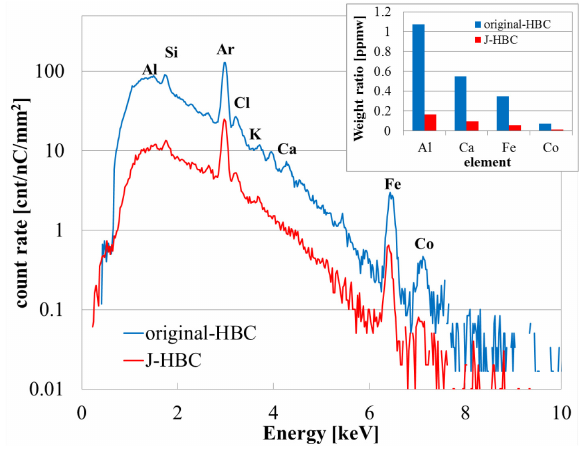
Fig. 6. Comparison of RBS spectra of original HBC foil and J-HBC foil (lower-left), and concentrations of trace impurities (upper-right).